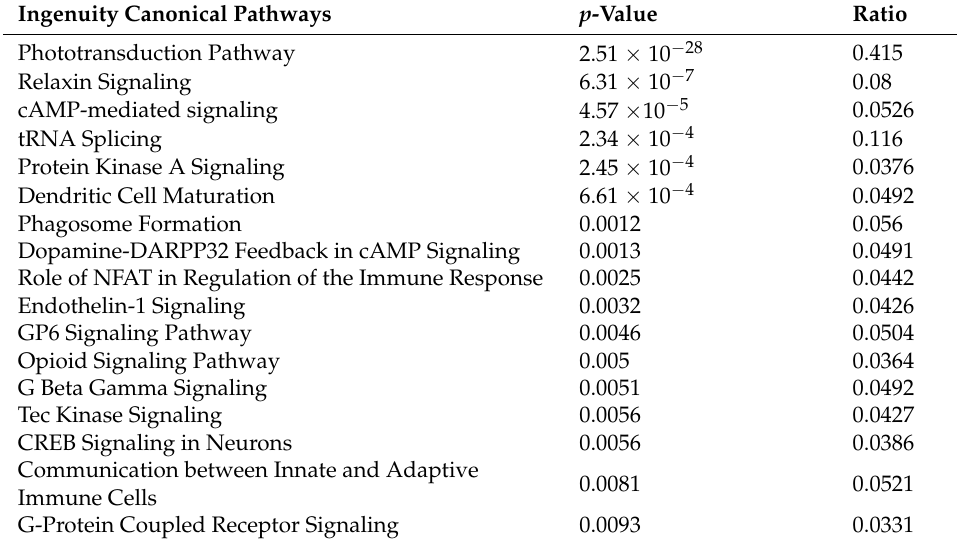
Table 2. Ingenuity canonical